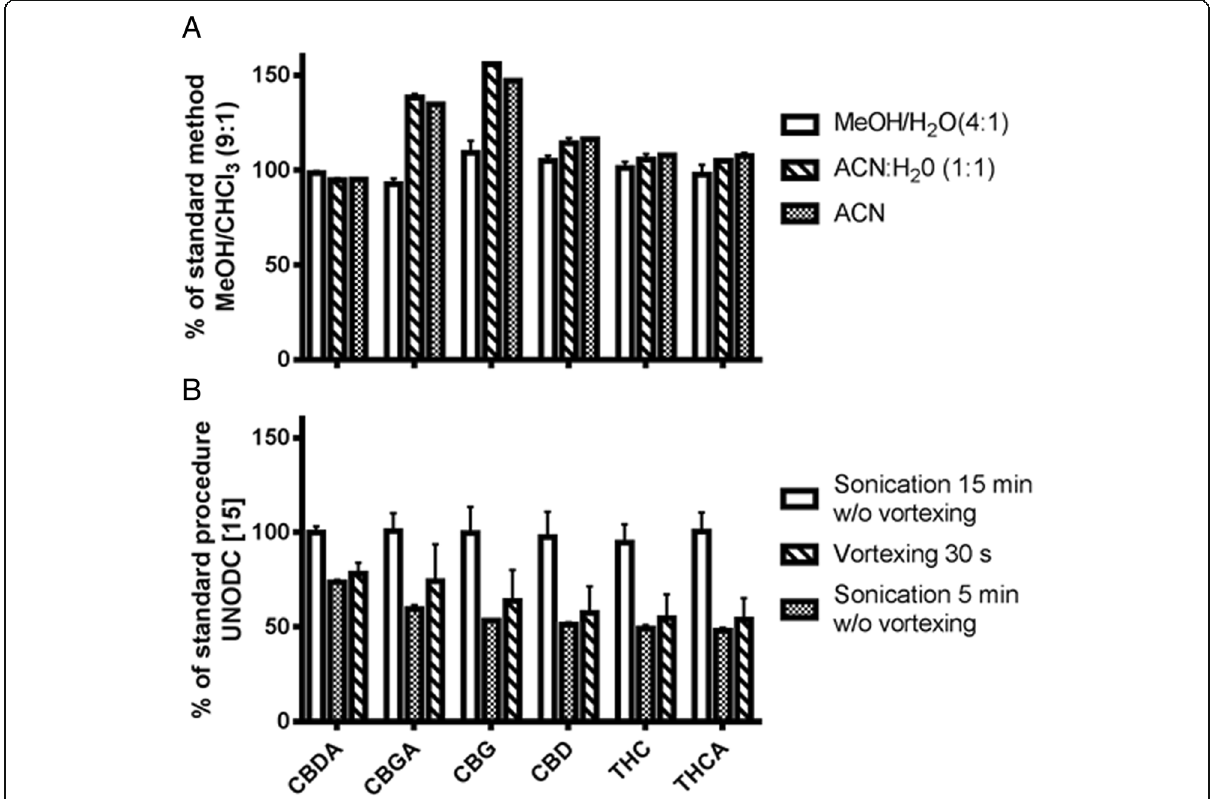
Fig. 3 a Data of different extraction solvents ( a ) and procedures ( b )